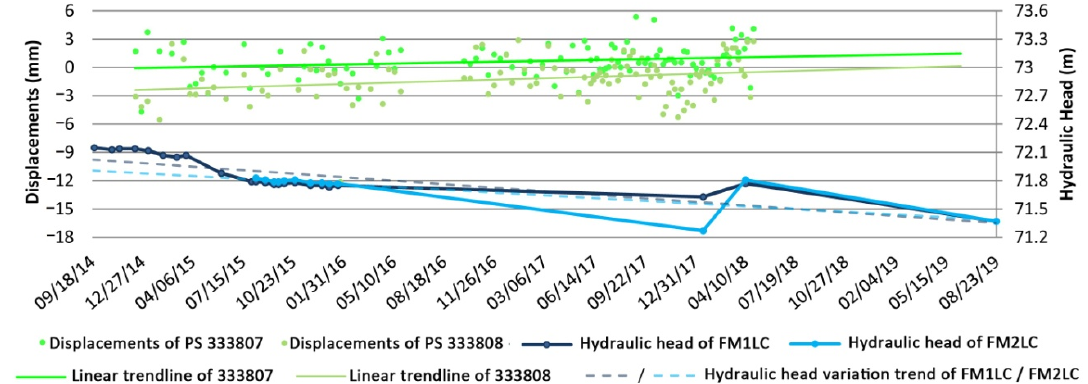
Figure 12. Correlation between displacements of PS points and hydraulic head of boreholes FM1LC and FM2LC. Left y -axis indicates displacements, right y -axis indicates hydraulic head variation, and x -axis indicates the time scale. Light and dark green dots represent the variations of the displacements in PS points 333807 and 333808. Light and dark green lines are the linear trends for the vertical displacements. Dark blue line represents the hydraulic head variation for borehole FM1LC in the confined middle aquifer. Light blue line represents the hydraulic head variation for borehole FM2LC in the shallow aquifer. Blue dotted lines represent the hydraulic head variation trend.